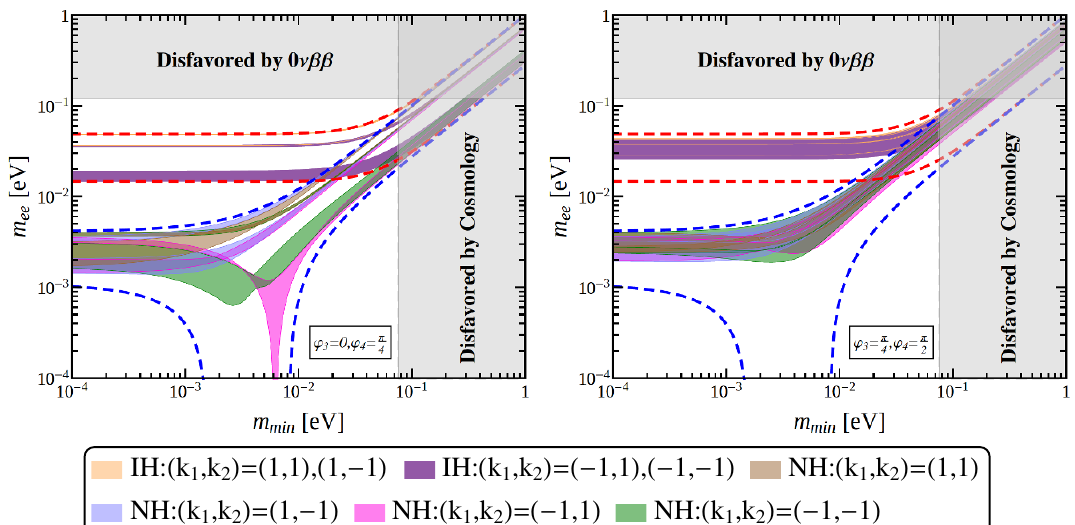
Figure 8 . The possible values of the e(cid:11)ective Majorana mass m ee as a function of the lightest L neutrino mass m min for mixing matrix U II ; 1 with n = 4. The red (blue) dashed lines indicate the most general allowed regions for IH (NH) neutrino mass spectrum obtained by varying the mixing parameters over their 3 (cid:27) ranges [8]. The present most stringent upper limits m ee < 0 : 120 eV from EXO-200 [85, 86] and KamLAND-ZEN [87] is shown by horizontal grey band. The vertical grey exclusion band denotes the current bound coming from the cosmological data of P m i < 0 : 230 eV at 95% con(cid:12)dence level obtained by the Planck collaboration